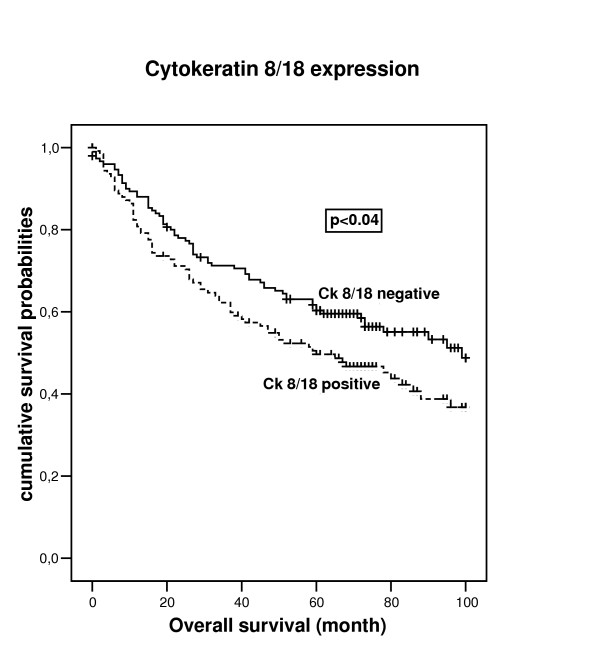
Overall survival of patient with oral squamous cell carcinoma in dependence on Cytokeratin 8–18 expression calculated by the Kaplan-Meier method.